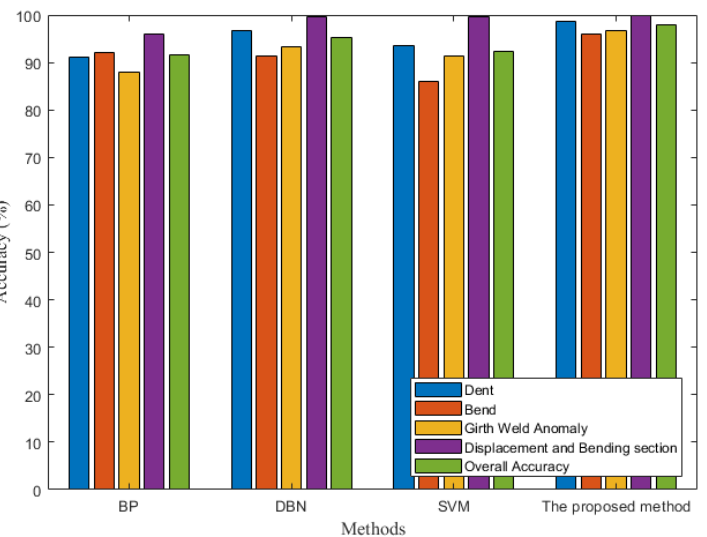
Table 2. Accuracy comparison of the different methods.